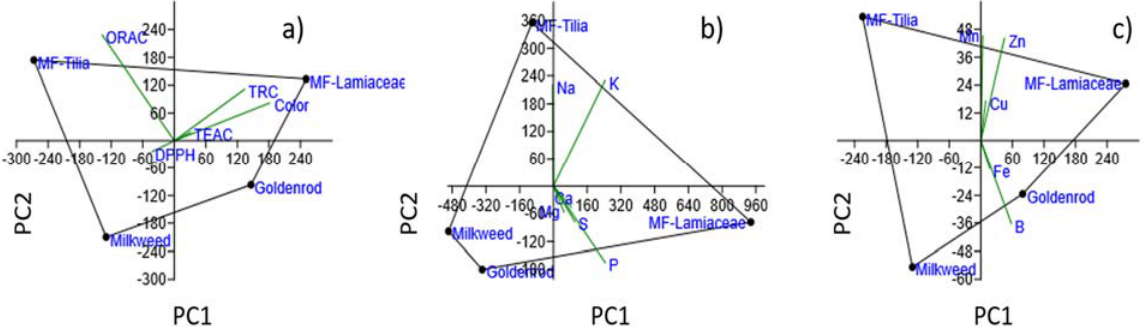
Figure 2. Principal component analysis (PCA) of dataset consisting of ( a ) antioxidant and color parameters, ( b ) macroelements and ( c ) microelements analyzed from the honey samples.